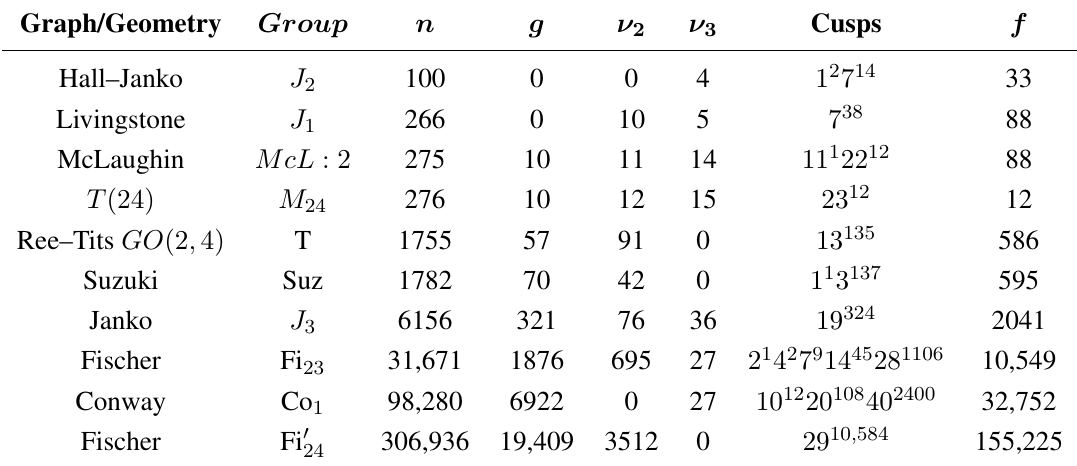
Table 2. Characteristics of a few small “sporadic” fundamental